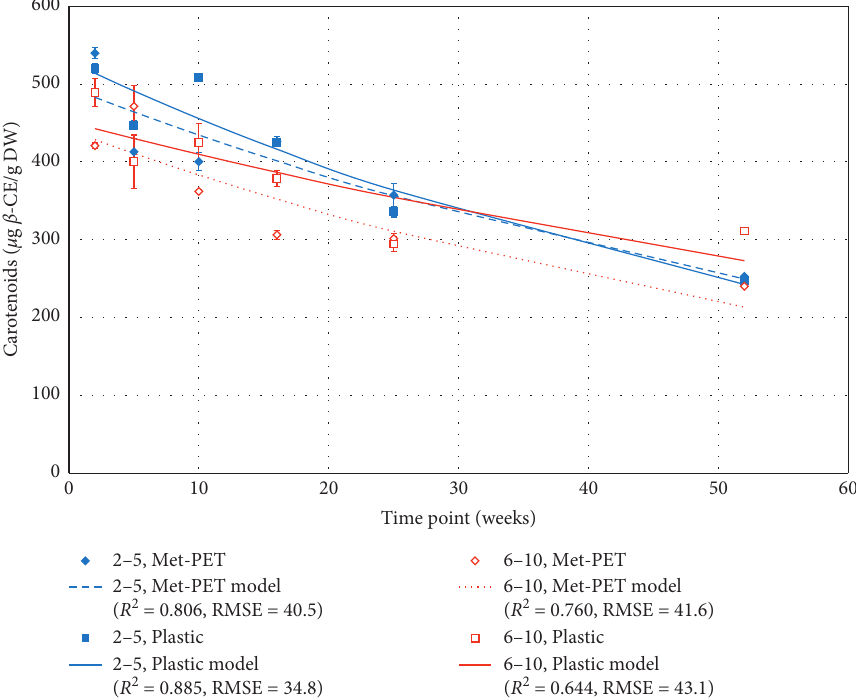
Figure 6: Mean levels of carotenoids of the persimmon chips over the 1-year course of the shelf-life study, overlaid with best-fit exponential decay (1 st -order kinetics) curves. Each error bar is constructed using 1 standard error from the mean. β -CE � β -carotene equivalents; DW � dry